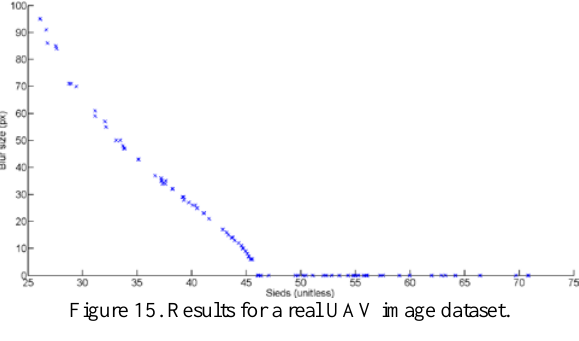
Figure 15. Results for a real UAV image dataset.